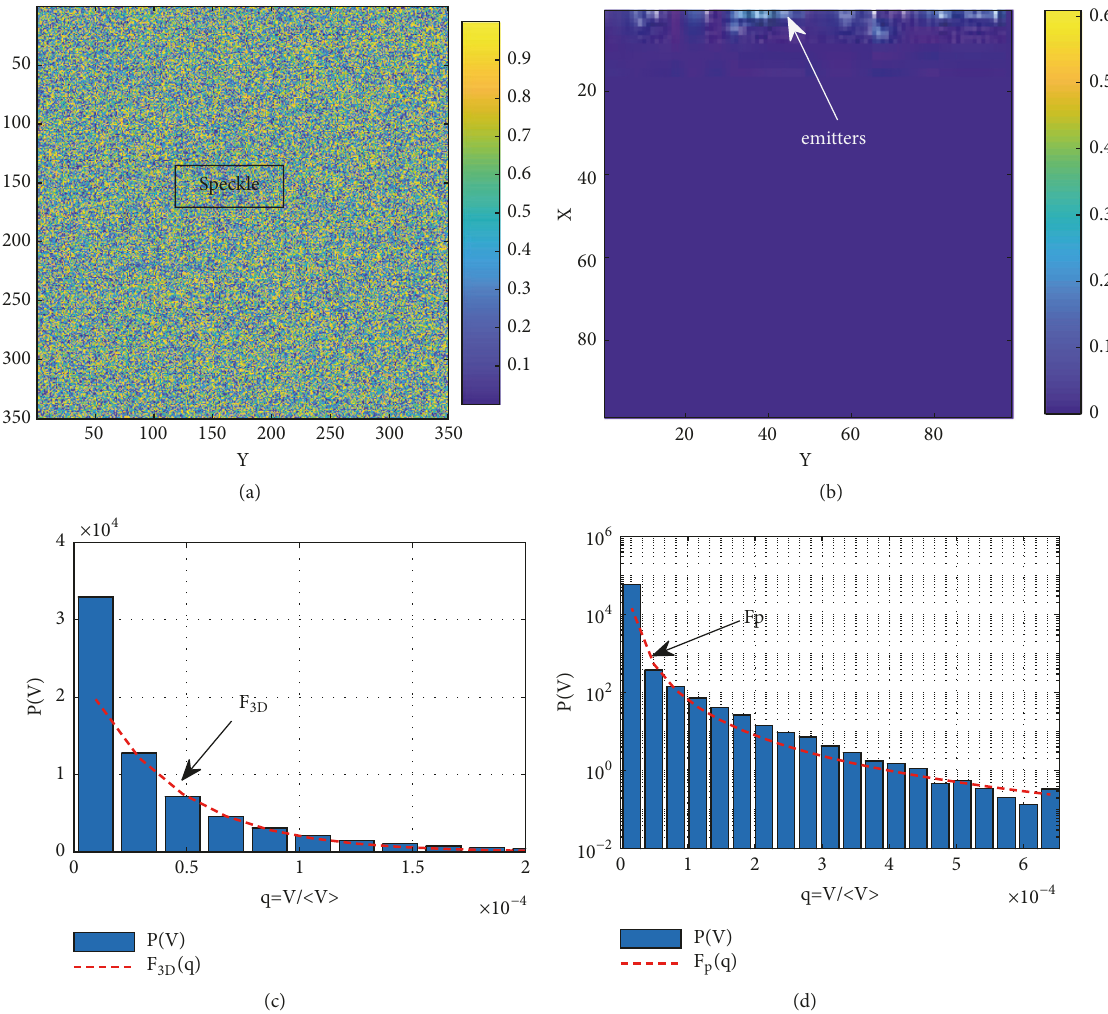
Figure 2: Thepropertiesof the specklepatternsgeneratedin 3Dcubewith 100×100×100 grids by random scatters(a),(c),and random optical emitters in percolating clusters(b),(d). (a) Central slice of the computer generated speckle pattern consisting of large number of independent scatterswith the phases uniformly distributed over [−𝜋,𝜋] ; (b) the field speckle pattern generated by radiated emitters (depicted as point-like spots) placed into a random percolating cluster with the population probability 𝑝 = 0.25 at small time 𝑡 = 1 ; (c) the histogram of intensity 𝑉 and the probability density function (dashed red line) 𝐹 (𝑞) = exp (−𝑞)/⟨𝑉⟩ for the pattern shown in (a); (d) histogram of intensity 𝑉 (in 3𝐷 exponential scale) and the (fitting) probability density function (dashed red line) 𝐹 𝑝 (𝑞) (see (6)) for the emitter pattern shown in (b). One can see that the probability density functions for (a) and (b) are different